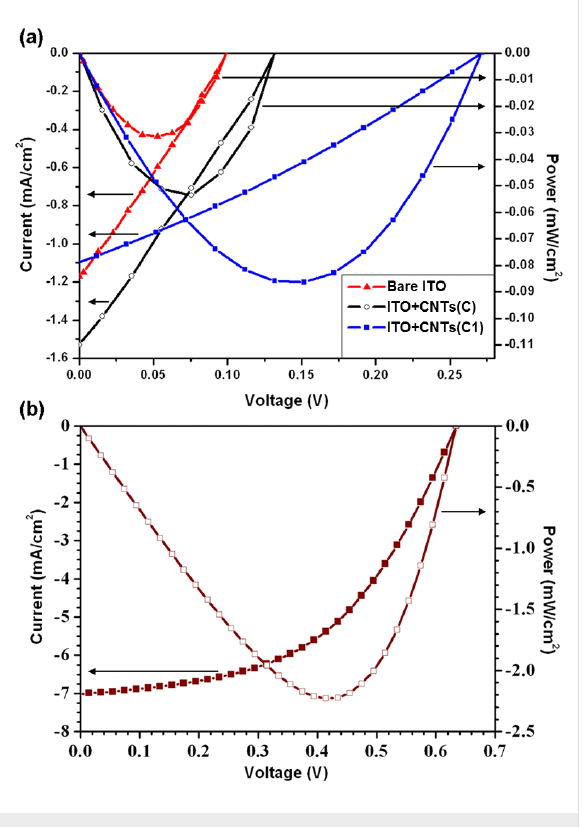
Figure 5: Current–voltage characteristic and output power of P3HT:PCBM solar cells: (a) Cell C and cell C1, compared to a refer- ence cell made with bare ITO-coated glass; (b) classic ITO/ PEDOT:PSS/P3HT:PCBM/Al cell manufactured in our labs.